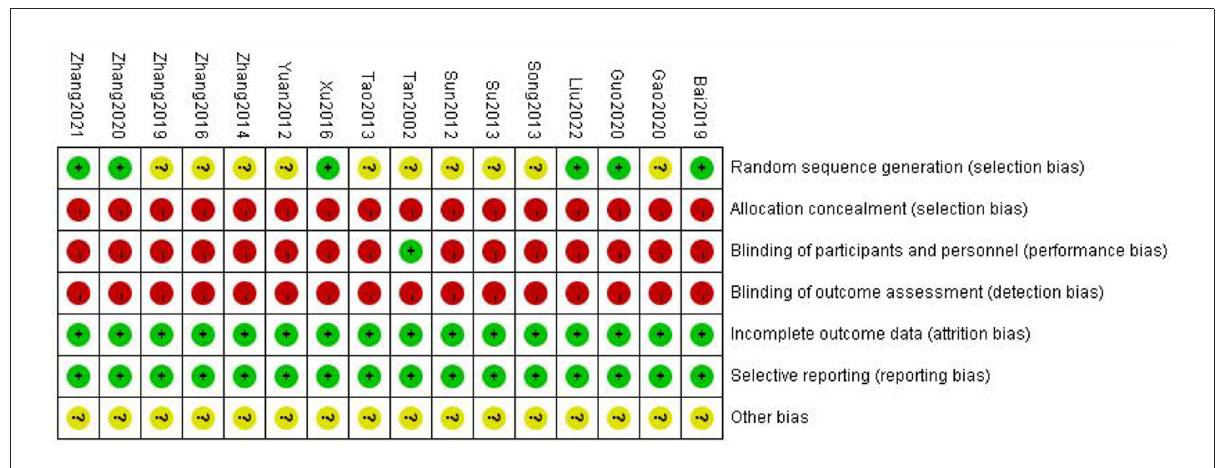
FIGURE3 Risk of bias